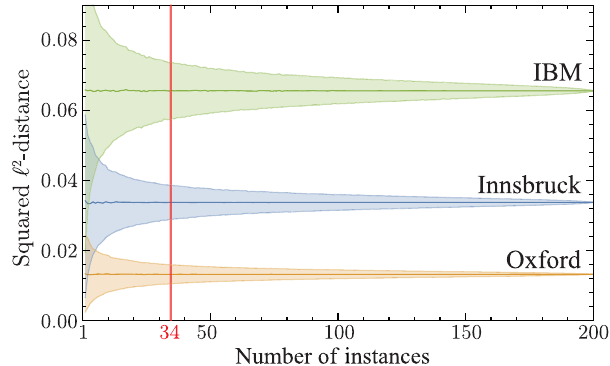
into account in this analysis.